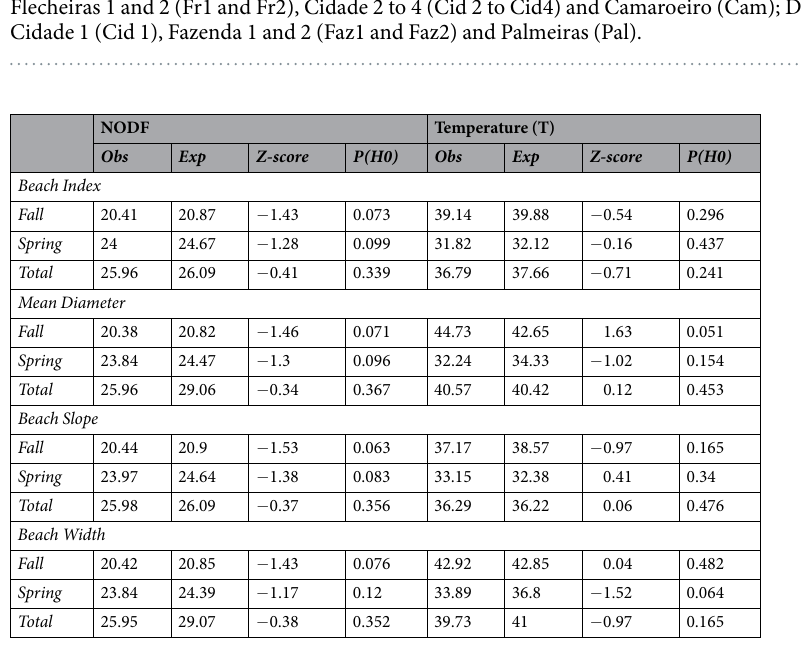
Table 4. Nestedness metrics for each beach characteristic used as a gradient to rank sites to identify nestedness